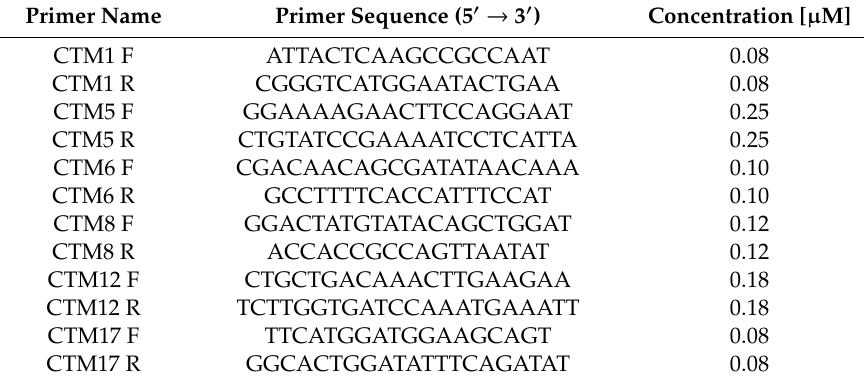
Table 1. Primers used in this study for the hexaplex-PCR